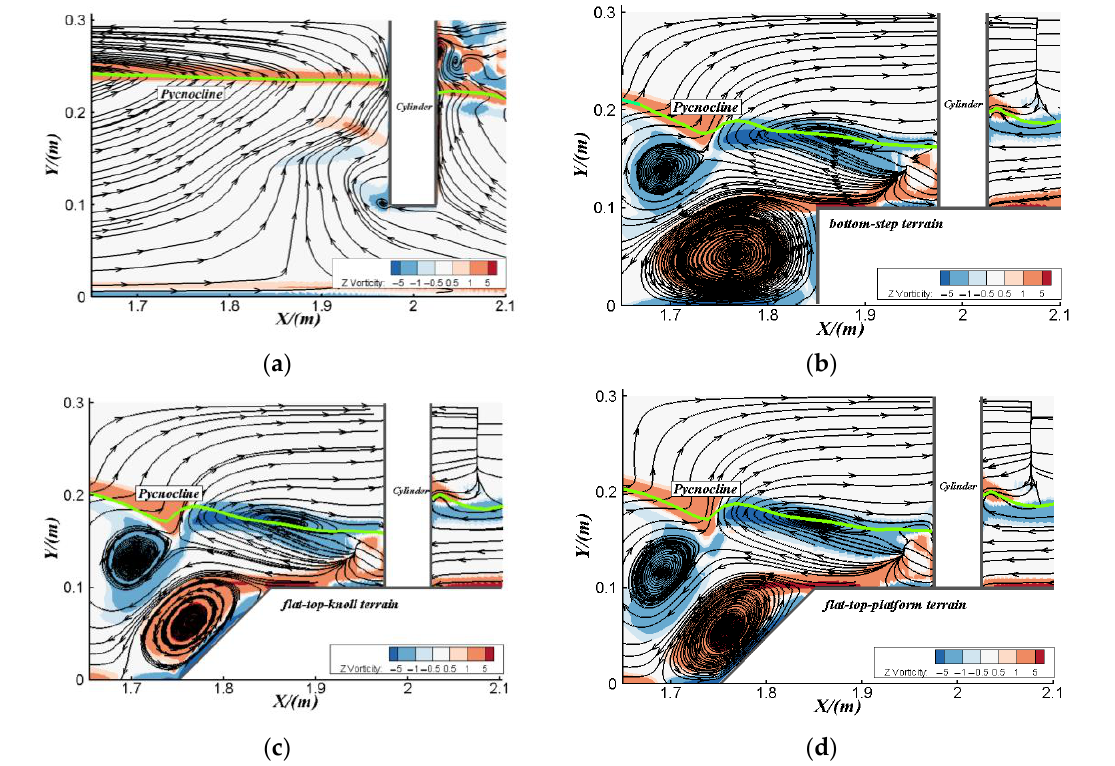
Figure 13. Plots of the flow field in Z direction, when C Fn = C Fn-max : ( a ) N 1 ,( b ) N 2 ,( c ) N 3 , ( d ) N 4.